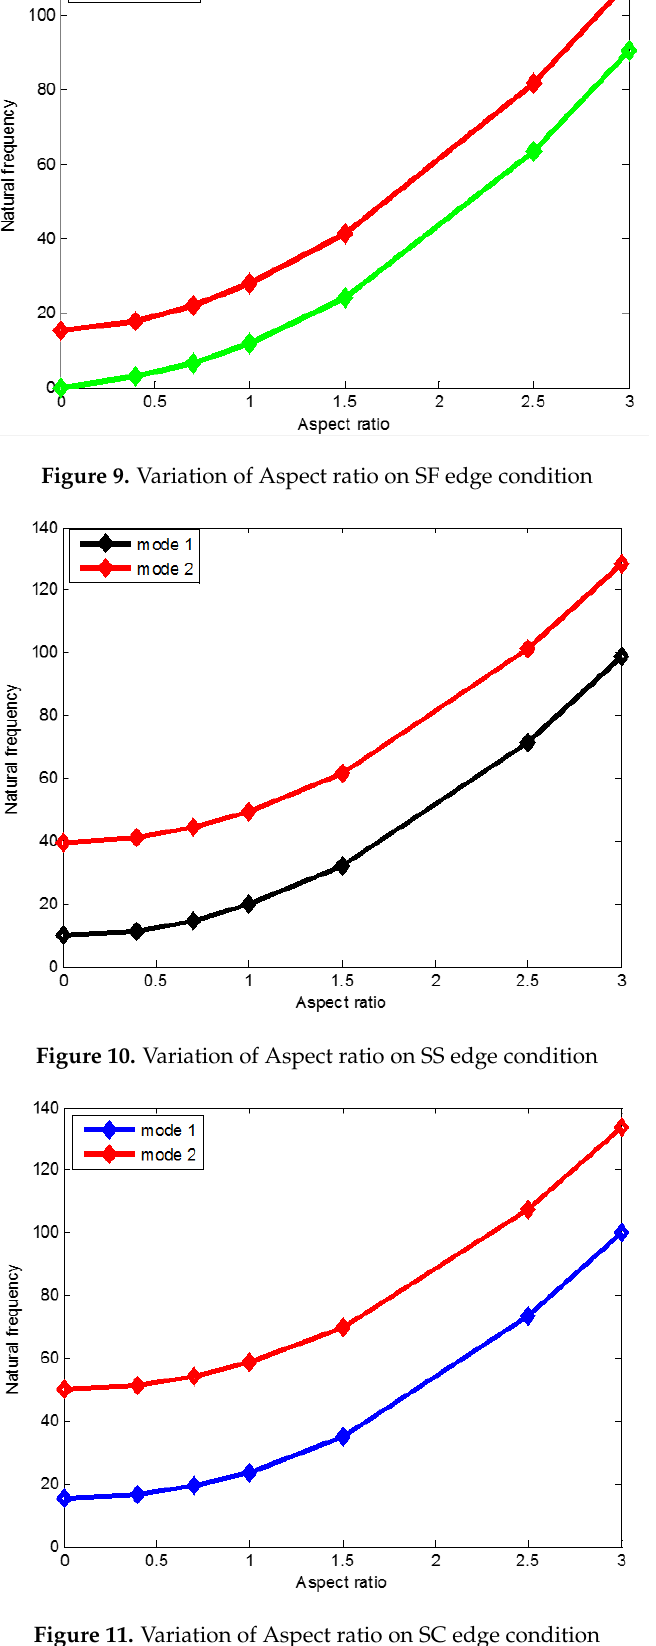
Figure 11. Variation of Aspect ratio on SC edge